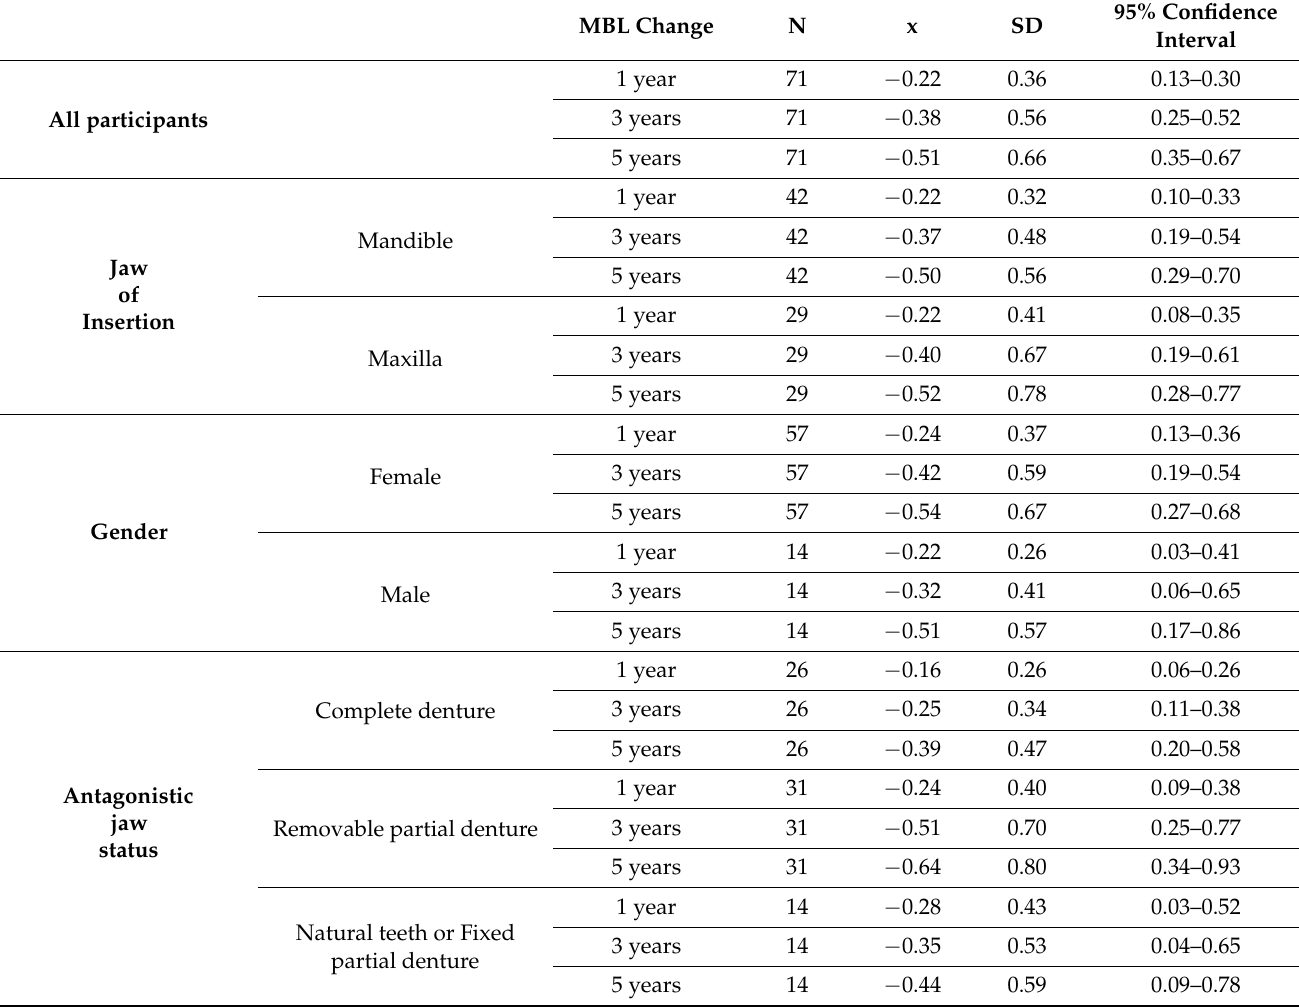
Table 2. Descriptive statistics for marginal bone level (MBL) changes over the observation period. MBL Change N x